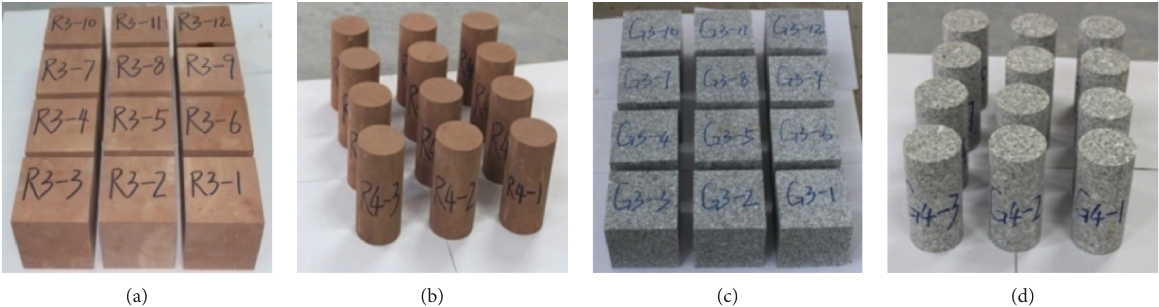
Figure 1: Test specimens. (a) Cubic red sandstone. (b) Cylindrical red sandstone. (c) Cubic granite. (d) Cylindrical granite.